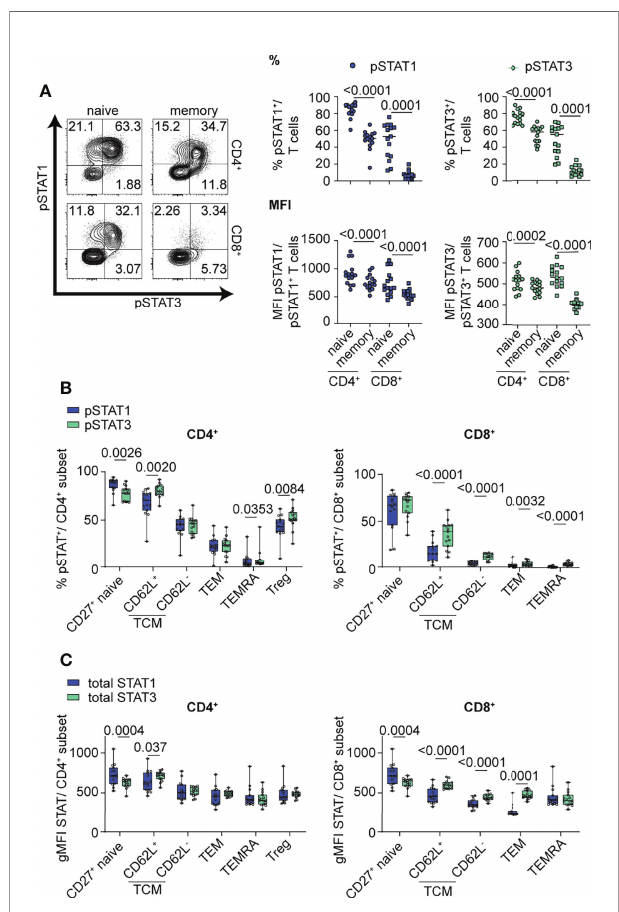
FIGURE 1 | IL-6-driven pSTAT1 and pSTAT3 responses differ in CD4 + and CD8 + T cell subsets. (A, B) CD3-enriched T cells were stimulated with IL-6 (20 ng/mL) for 30 min or (C) left unstimulated and the pSTAT1 and pSTAT3 response or levels of total STAT1 and STAT3 protein were determined by fl ow cytometry. (A) Representative fl ow plot of pSTAT response (left) and frequencies and MFI of gated pSTAT1 + or pSTAT3 + cells among naïve (CD45RA + ) or memory (CD45RA - ) CD4 + (non-Treg) and CD8 + T cells (right) or (B) among CD4 + and CD8 + T cell subsets in the context of T cell maturation. (C) gMFI expression levels of total STAT1 and STAT3 protein were measured in CD4 + and CD8 + T cell subsets in the context of T cell maturation. ( A – C ) Wilcoxon matched-pairs signed rank test. n =